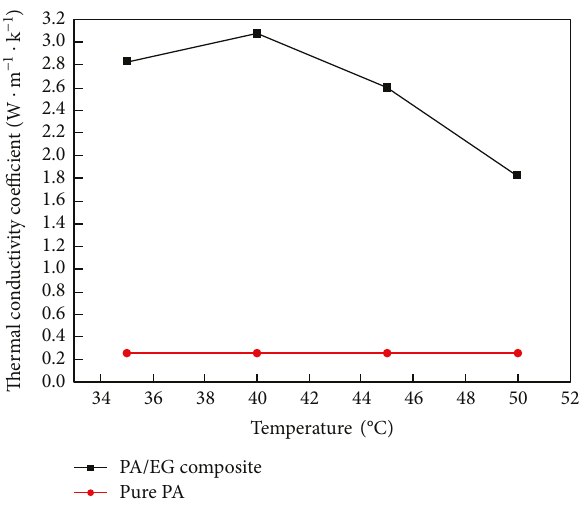
Figure 6: Thermal conductivity analysis between pure PA and PA/EG composite